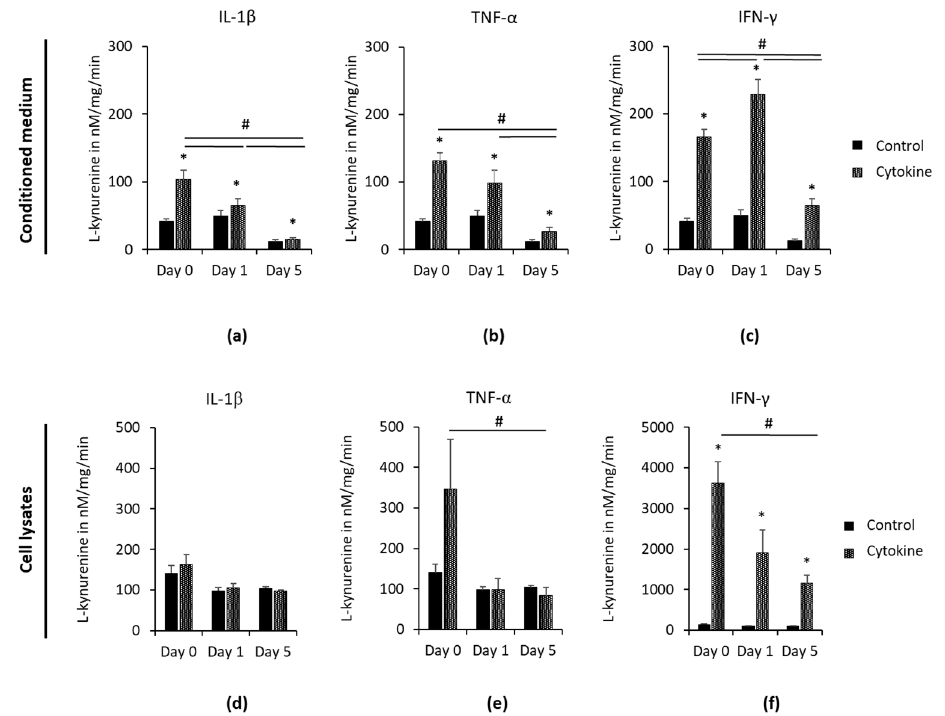
Figure 3. Continuing effect of IL-1 β , TNF- α or IFN- γ on IDO-1 enzymatic activity in hPDLSCs. Primary hPDLSCs were stimulated with 5 ng/mL IL-1 β ( a , d ), 10 ng/mL TNF- α ( b , e ) or 100 ng/mL IFN- γ ( c , f ). After 48 h of incubation, the medium was changed to DMEM without any inflammatory stimuli. IDO-1 enzymatic activities were calculated via measuring L-kynurenine concentrations in CM ( a – c ) and cell lysates ( d – f ) immediately and one and five days after removing inflammatory stimuli. Determined L-kynurenine levels were normalized by the total protein amount per sample and the appropriate incubation times. The y -axis shows the L-kynurenine concentrations in nM/mg/min in a linear scale. All data are presented as mean (±S.E.M.) obtained from 4 independent experiments using hPDLSCs isolated from 4 different individuals. * p -value ≤ 0.05, significantly increased compared to the unstimulated control of the appropriate day; # p -value ≤ 0.05, significantly different between groups as indicated.